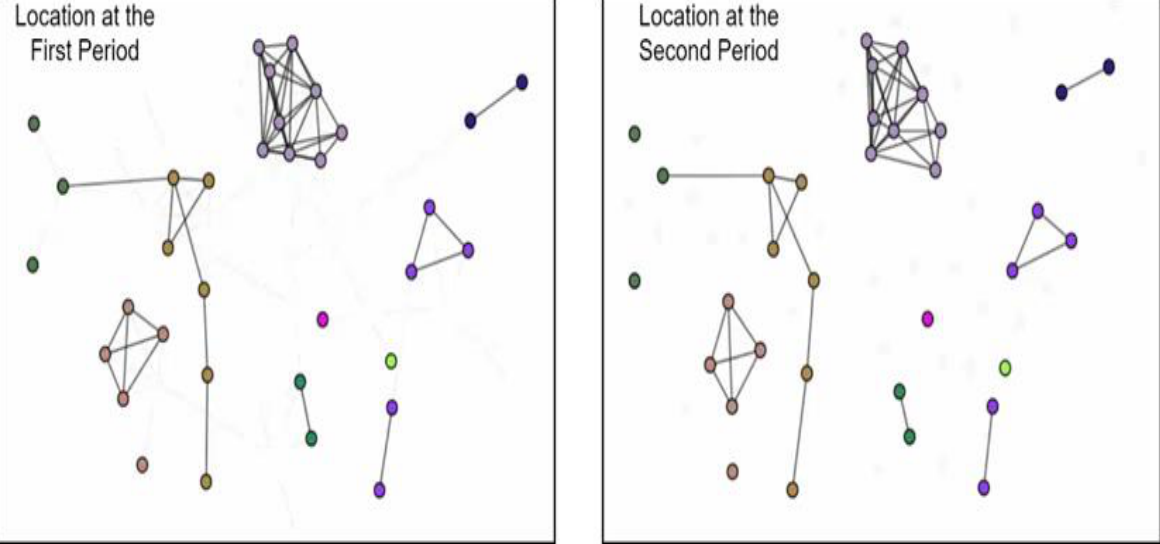
Figure 11. Transition from the first to the second period with mental map preservation.